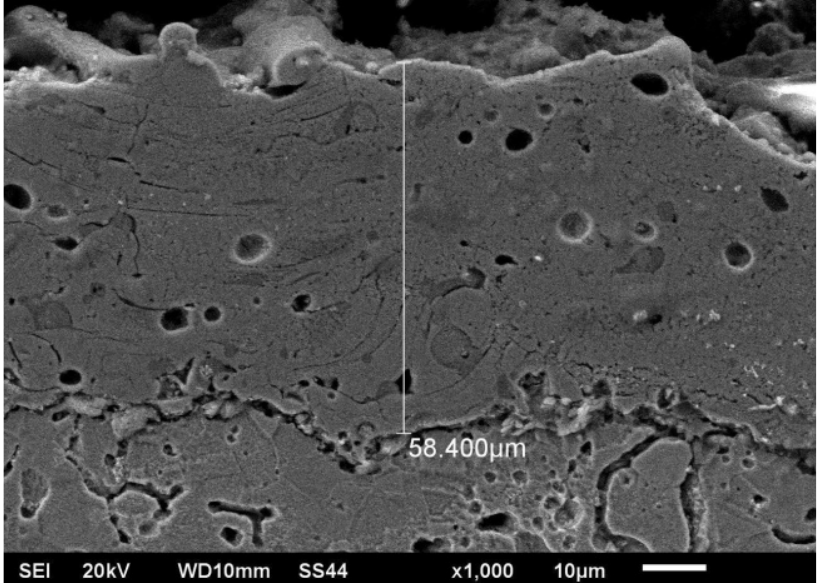
Figure 3. Microstructure of the Cr 3 C 2 –NiCr coating after the APS process for SSS.